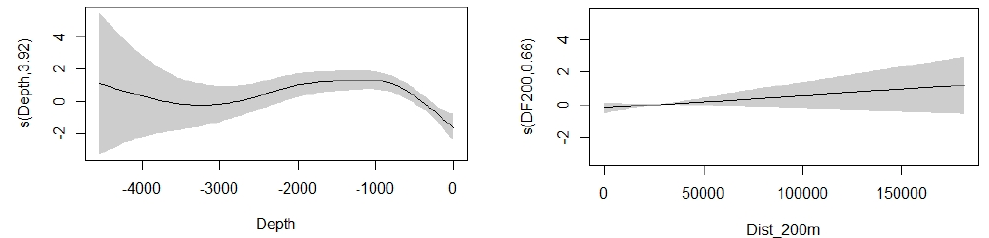
Figure 6. Smooth functions for depth and distance from 200 m isobaths. Grey shading corresponds to 95% confidence levels, and numbers in brackets on the vertical axis labels give the effective degrees of freedom of the term.